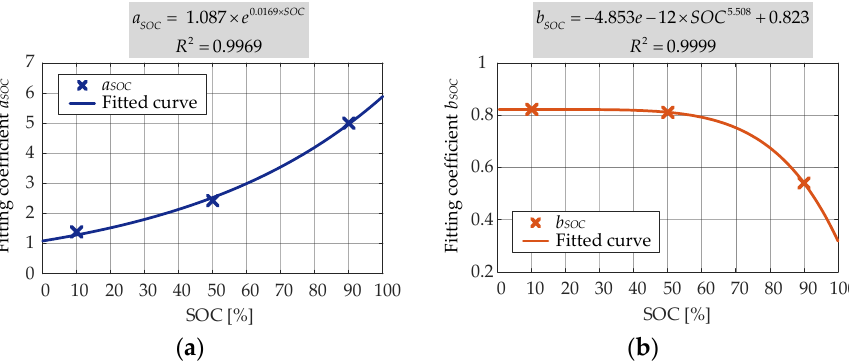
Figure 11. The relationship between the curve fitting coefficients and the corresponding storage SOC level. ( a ) Exponential relationship between a SOC and SOC , ( b ) Power relationship between b SOC and SOC .